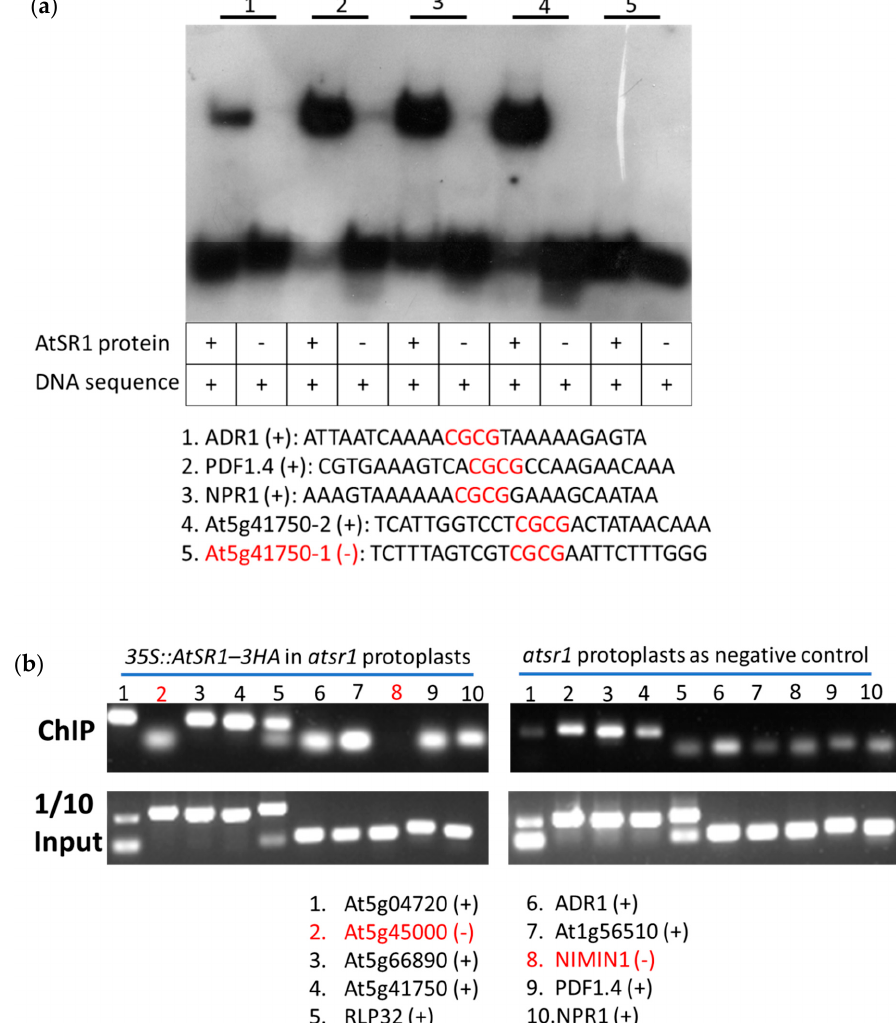
Figure 6. AtSR1 binding to the promoters of defense-related genes. ( a ) Promoter fragments of defense-related genes and purified recombinant AtSR1 protein were used in EMSA assay. At5g41750-1 in red indicates negative result ( − ). ( b ) The ChIP’ed DNA was amplified with primers flanking the CGCG box in the promoters of defense-related genes. At5g45000 and NIMIN1 in red indicates negative results ( − ). See also Table 1.